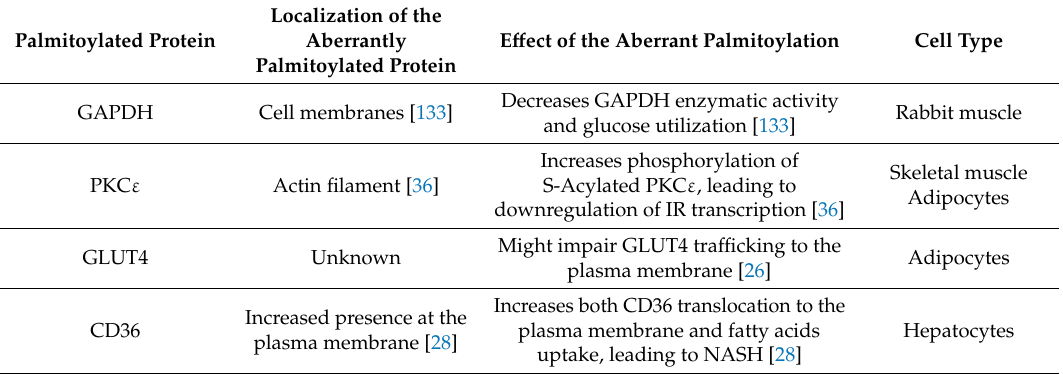
Table 2. Aberrant protein palmitoylation driving insulin